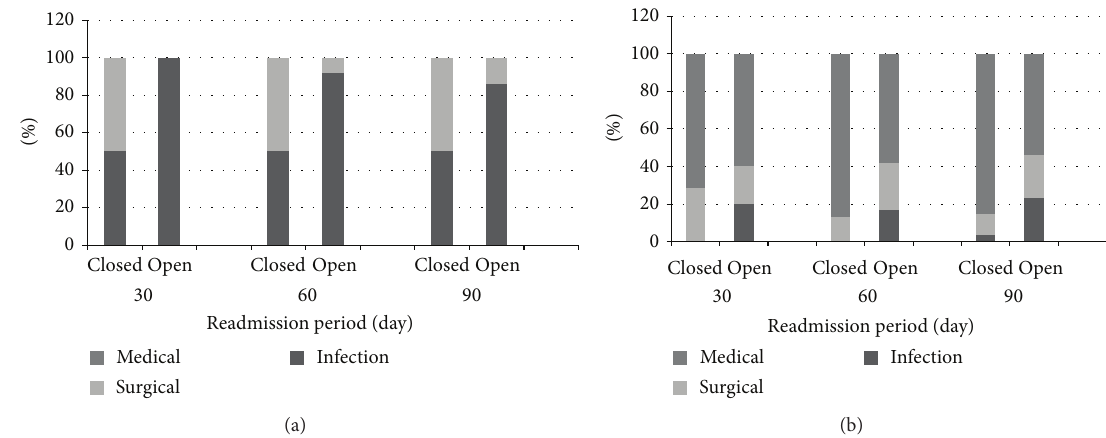
Figure 2: (a) Patients readmitted for isolated diaphyseal open and closed tibia fractures classified by reason for readmission. (b) Patients readmitted for isolated diaphyseal open and closed femur fractures classified by reason for readmission. Note . All orthopaedic trauma surgery patients who presented with a diaphyseal tibia or femur fracture to VUMC between January 1, 2004, and December 31, 2006, were included in this analysis. Reasons for readmissions were classified as “infection” (postoperative infection), “surgical” (postoperative surgical revision), and “medical” (nonoperative medical conditions such as UTIs, PNAs, hypotension, and